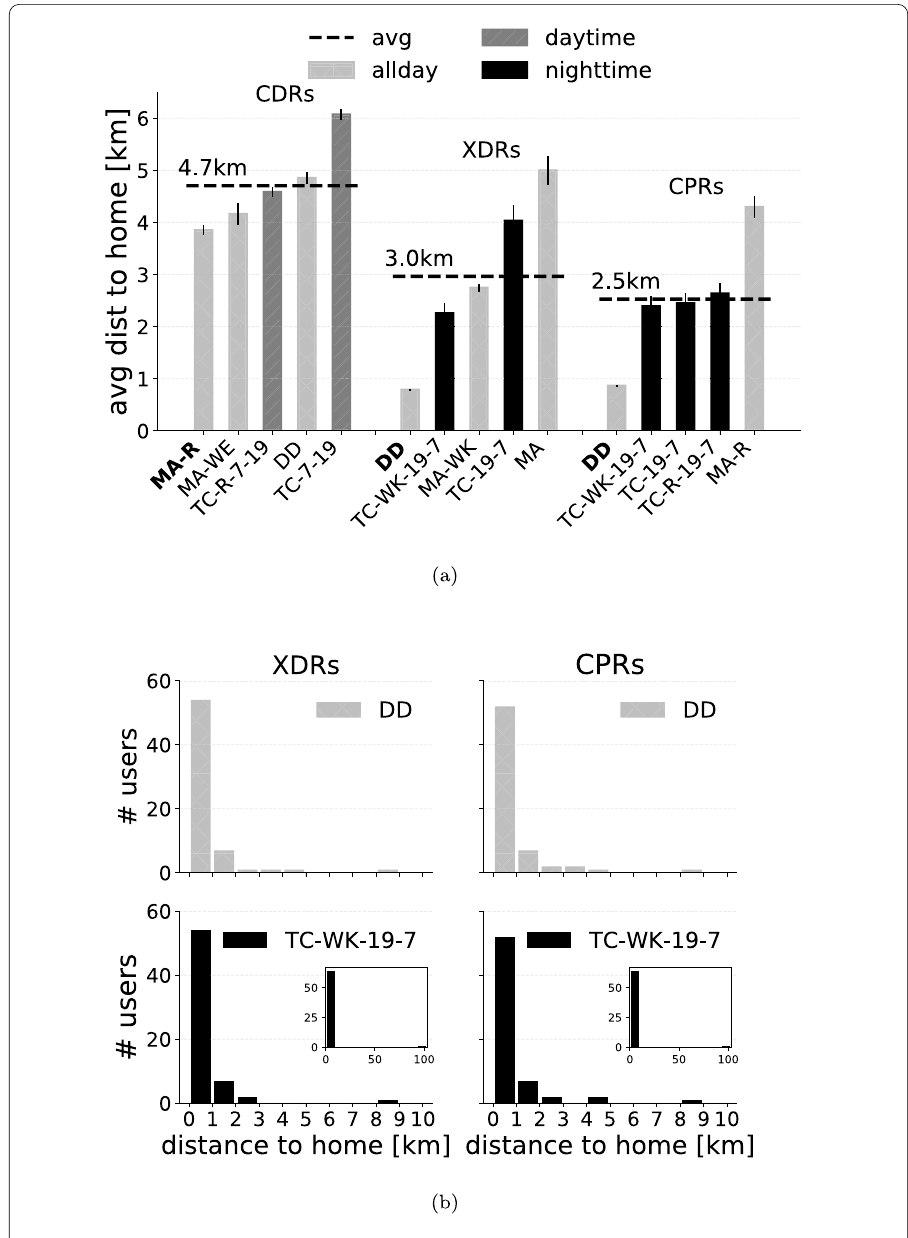
Figure 7 ( a ) Average distance between the home location detected by each HDA ( k = 1, any of the three closest towers) on each stream and the actual user’s home location. ( b ) Distribution of the distance to the actual home for DD and TC-WK-19-7 on XDRs and CPRs